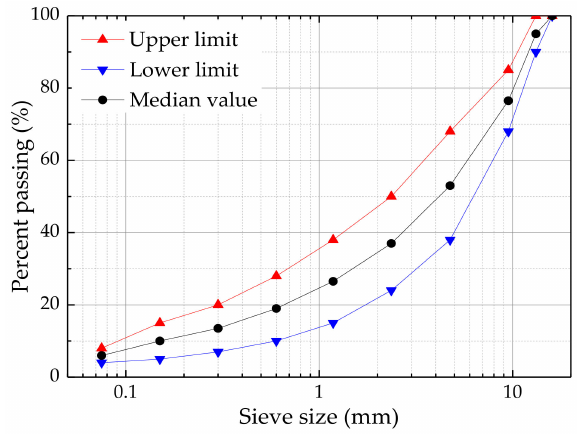
Figure 2. Gradation of the asphalt mixture